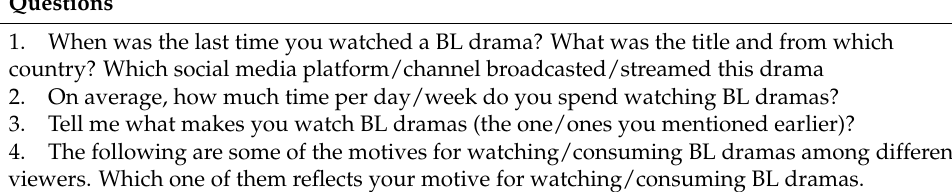
Table 2. Interview